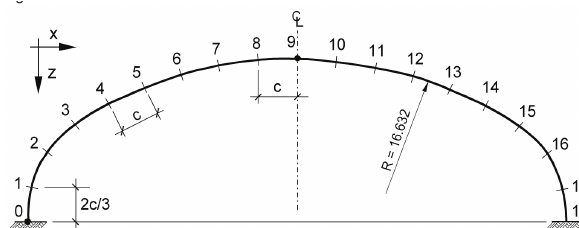
Figure 4: Arrangement of measuring points on the circumferential section of shell, as well as the 2D